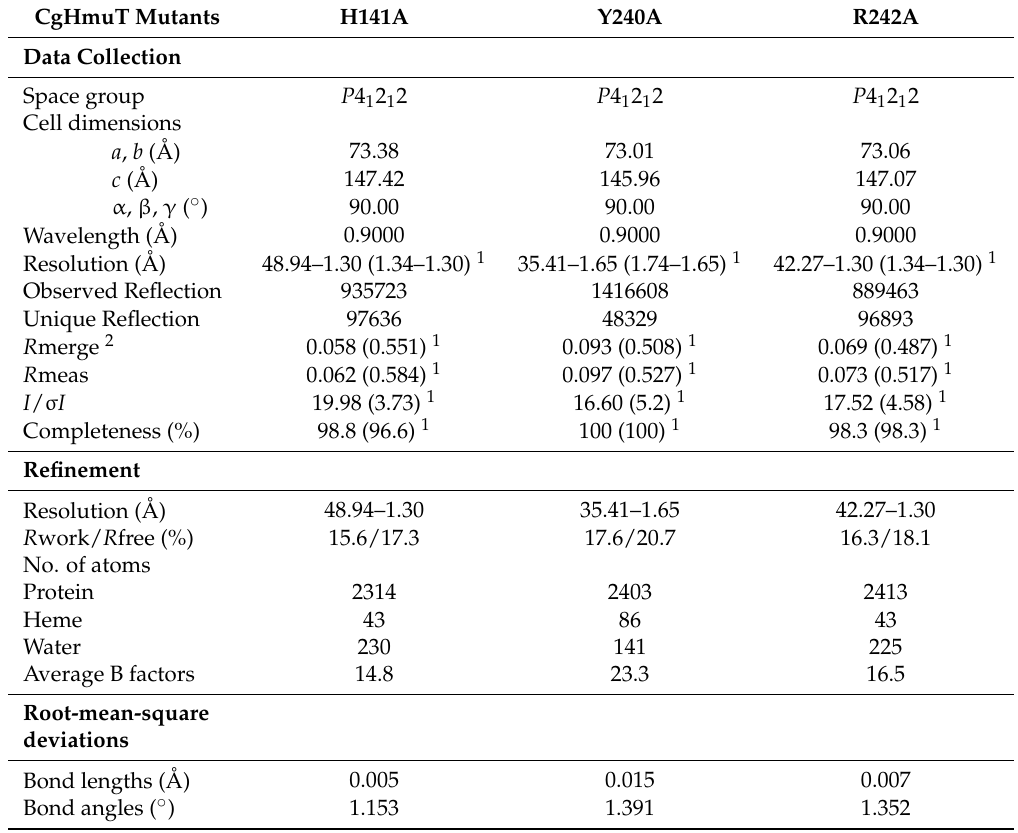
Table 1. A summary of the data collection and refinement